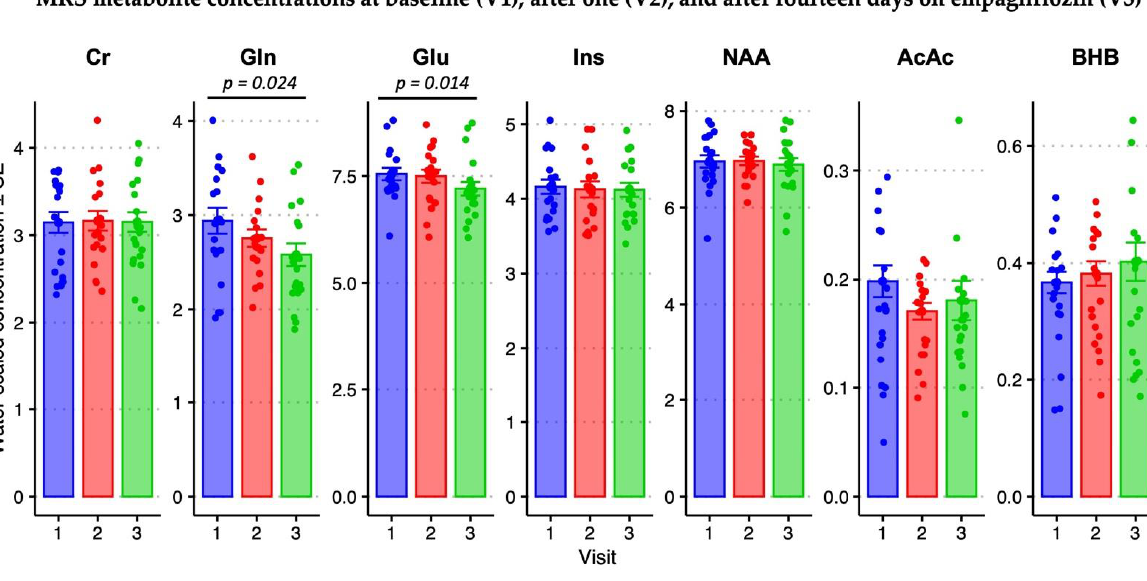
Figure 4. Select precuneal water-scaled MRS metabolite concentrations (mmol/L) over the three study visits. Standard error bars indicate the water-scaled concentration of Creatine (Cr), Glutamine (Gln), myo-Inositol (Ins), N-acetyl aspartate (NAA), Acetoacetate (AcAc) and beta-hydroxybutyrate (BHB). Statistical analysis involved repeated-measures linear mixed models with “Visit” as the repeated -measures variable and concentration as the dependent variable. Additional factors and covariates are detailed in the Statistical Methods section (2.9). Bars and error bars are shown for baseline (visit 1 t 0 (1)), 24 h after the first dose (visit 2 t 24 (2)), and 24 h after the last dose (visit 3 t 24 (3)). Significant results for the omnibus test across all three visits are indicated by a black horizontal bar above the individual plot, with the p -value above. Table 4. MRS metabolite reliability measures, descriptive statistics, and omnibus statistical results over the baseline (V1), after one dose (V2), and after multiple (V3) empagliflozin doses. Metabolite